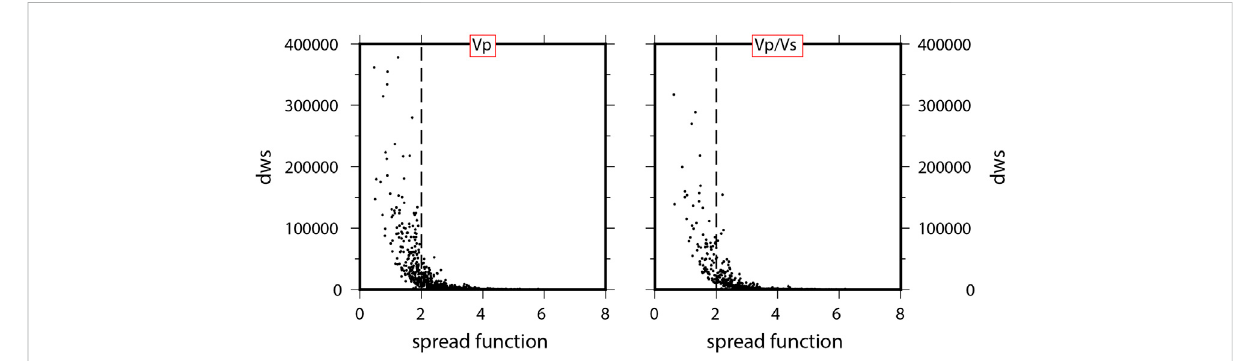
FIGURE 3 Two-dimensional plots of the Derivative weight sum (DWS) versus the Spread Function (SF) for Vp and Vp/Vs parameters. In each plot, the dashed vertical line indicates SF = 3. This value represents the kink of the L-shaped trend that represents the upper threshold of SF that ensures a good resolution and negligible smearing effects (Toomey and Foulger,